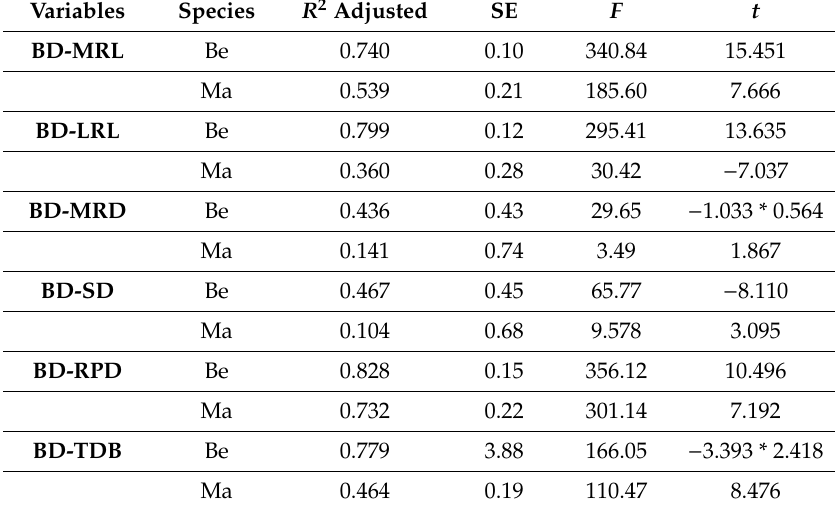
Table 3. Values of R 2 adjusted, standard error (SE), F, and t for relationship between bulk density and seedlings morphology and biomass that shows in Figure 2.